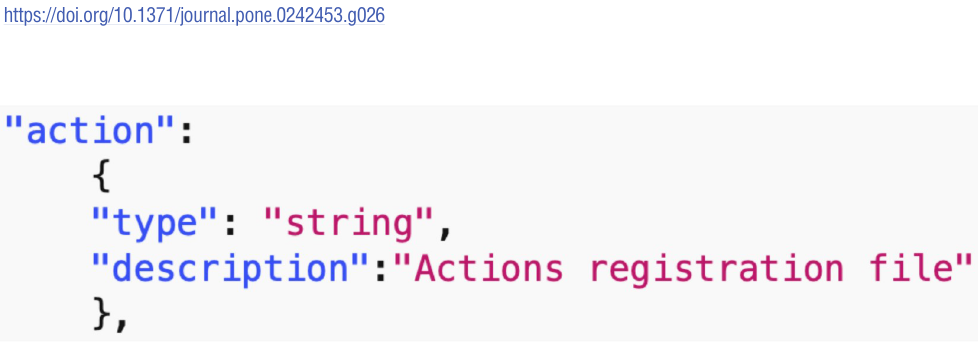
Fig 27. To run a pipeline (called a job), a configuration input file specifies functions and their order of execution. This Figure shows a portion of the schema for a configuration file that specifies the action description JSON schema file location.